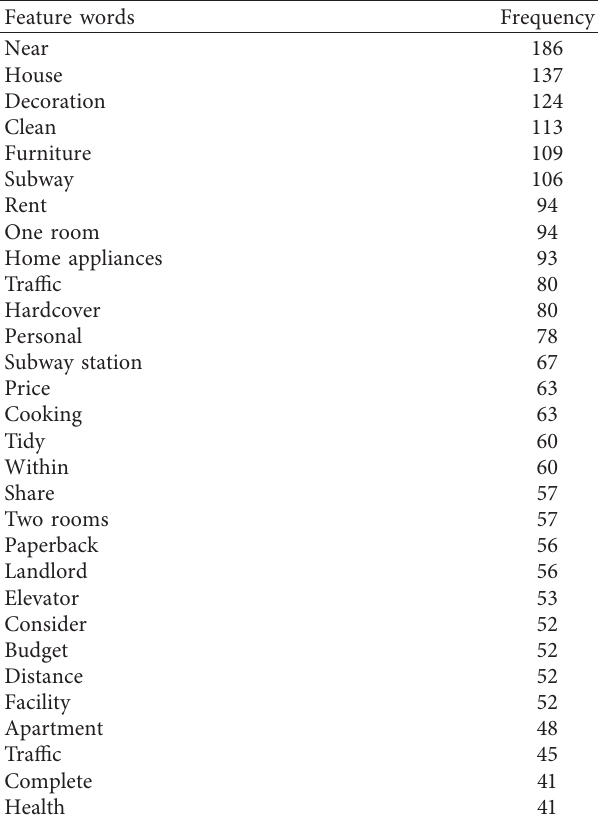
Figure 5: Workflow for crawling rent-seeking information on 58. Table 2: Tenant’s rent-seeking information: frequency of feature words (top 30).